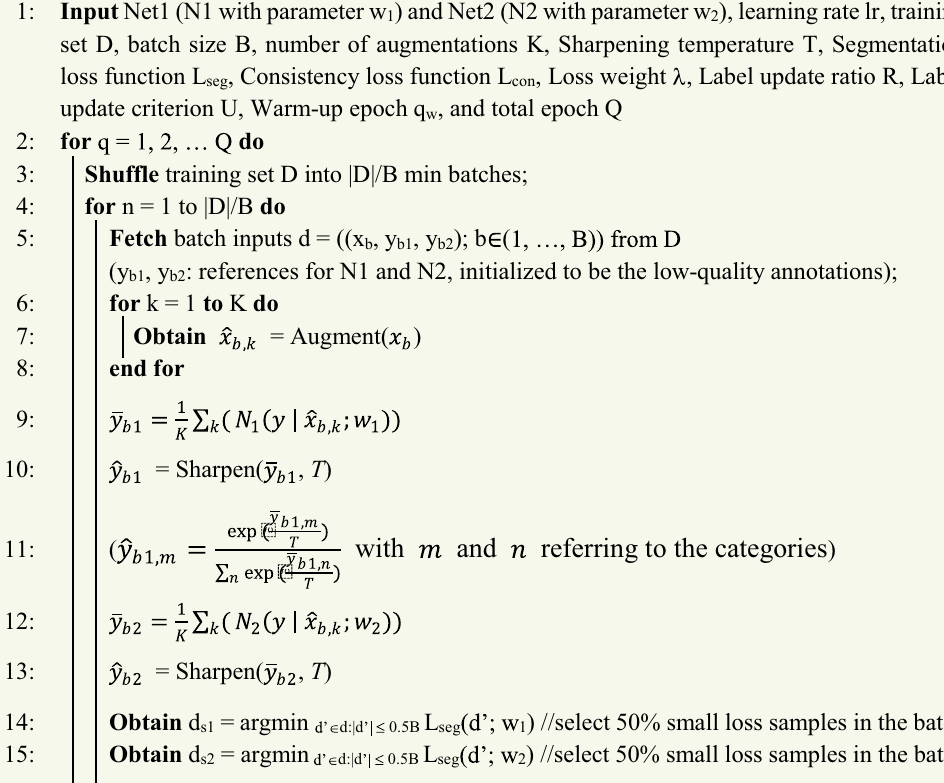
Algorithm 1 | Cross-Model Self-Correcting Mechanism of AIDE.